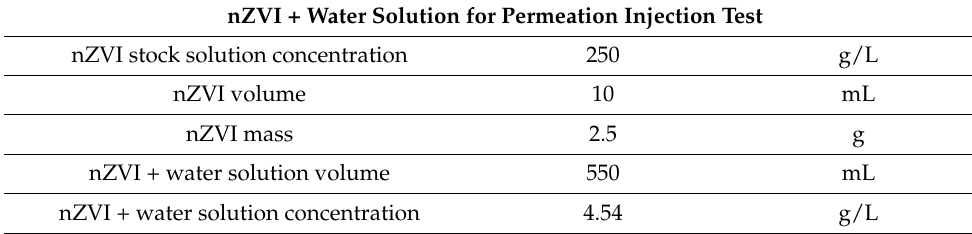
Table 3. Features of nZVI + water solution used during permeation injection